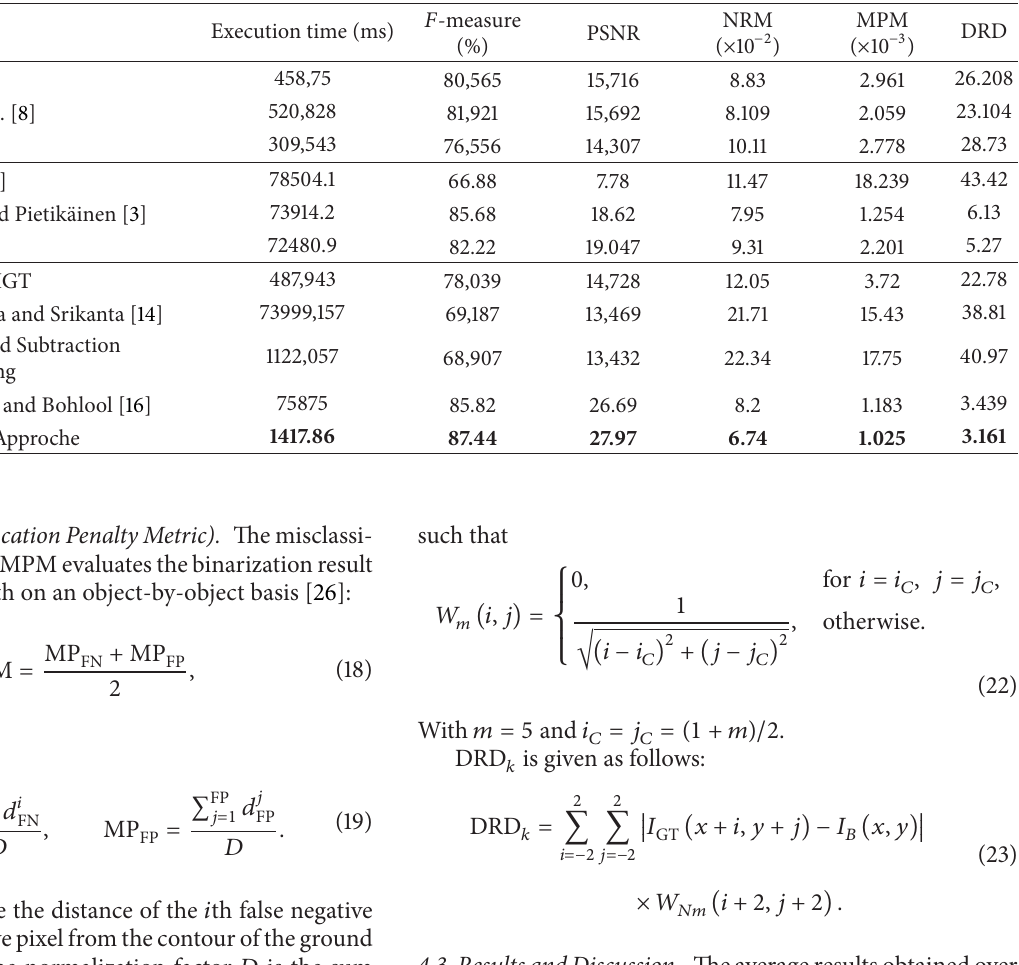
Table 2: Average results obtained on the test